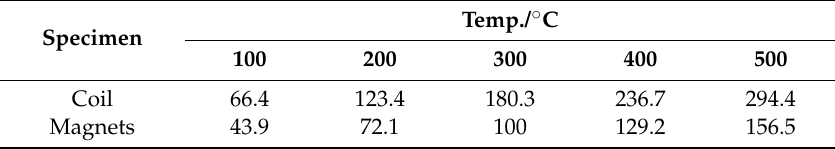
Table 1. Temperature of components of final Electromagnetic Acoustic Transducers (EMAT) design.